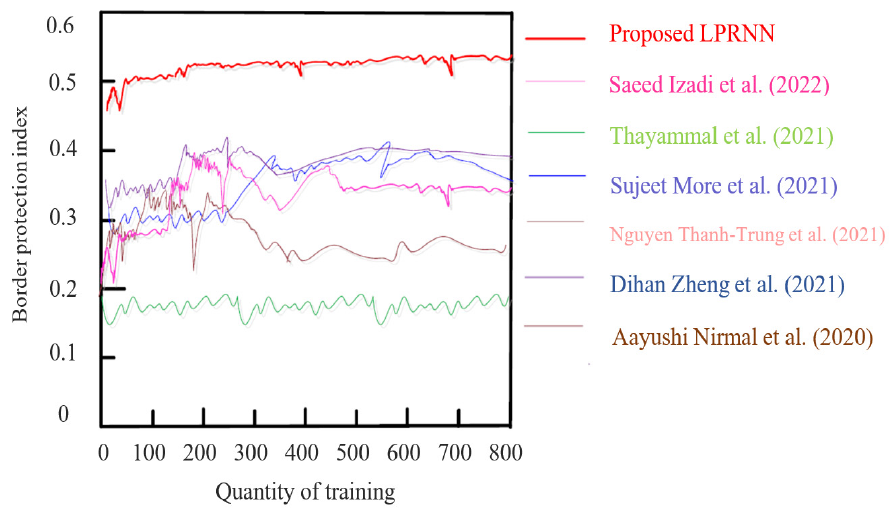
Figure 6. Graphical view of image noise removal different state-of-art-method [5,6,8,9,11,14]. Figure 7 depicts the BPI range after local speckle noise destruction. Selecting an ultrasound breast image from the INbreast dataset and the CBIS-DDSM dataset allowed us to denoise the local speckle noise in the ultrasound breast image and examine the intuitive impact of the proposed method on the noise removal of ultrasound image local speckle noise. Figure 8 shows the difference in image quality before and after speckle noise reduction was applied. Figure 8, shows that local speckles were abundant in the initial ultrasound breast images taken from both datasets, leading to erroneous conclusions about the breast’s health and the potential for minor lesions to be missed.